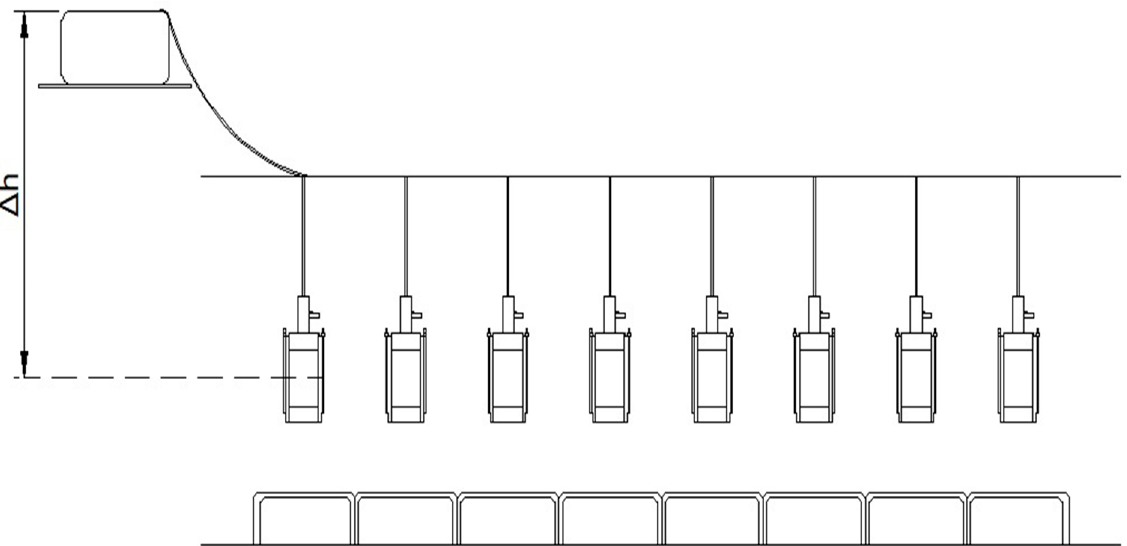
Figure 3. Set-up used for the permeability tests.